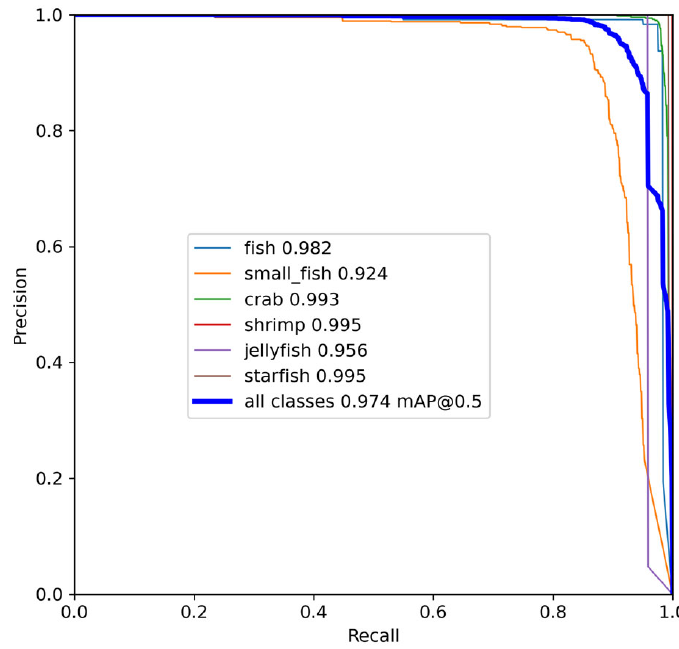
Table 5. Anchor box parameters of the Brackish dataset.